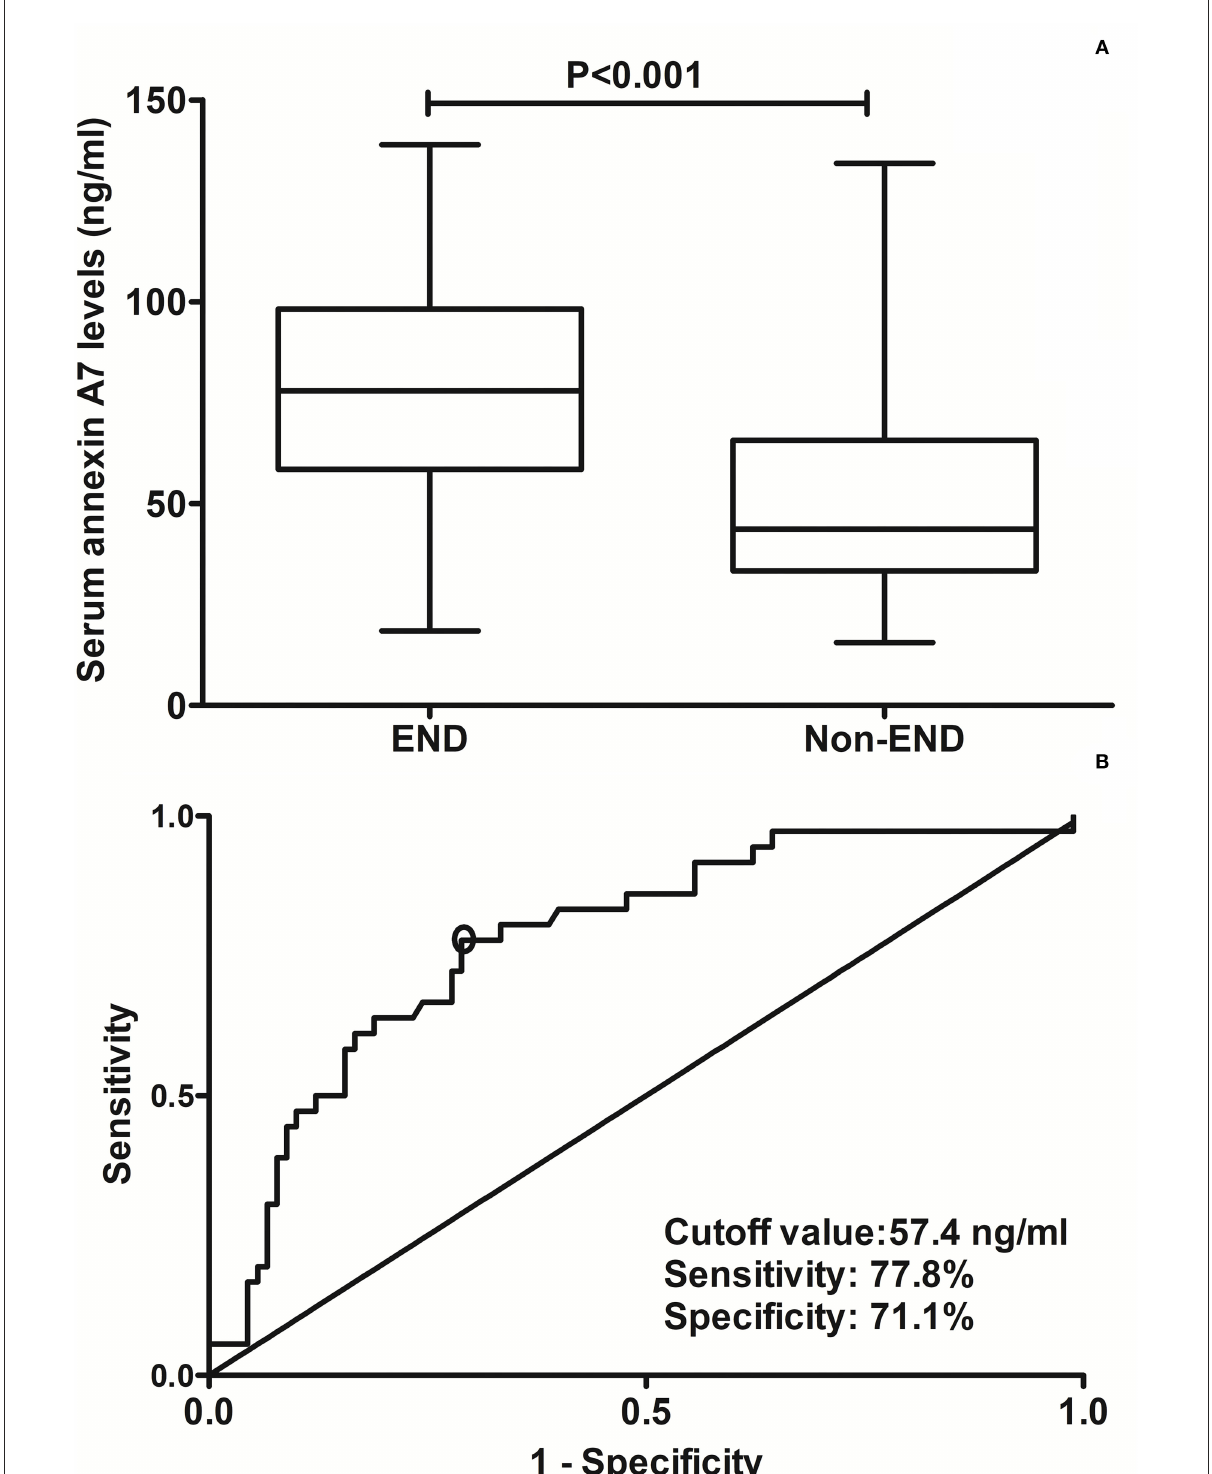
FIGURE4 Analysis regarding the predictive value of serum annexin A7 levels for early neurological deterioration after acute intracerebral hemorrhage. (A) Comparison of serum annexin A7 levels between patients with development of early neurological deterioration and those not presenting with early neurological deterioration. (B) Assessment of the discriminatory ability of serum annexin A7 levels for early neurological deterioration